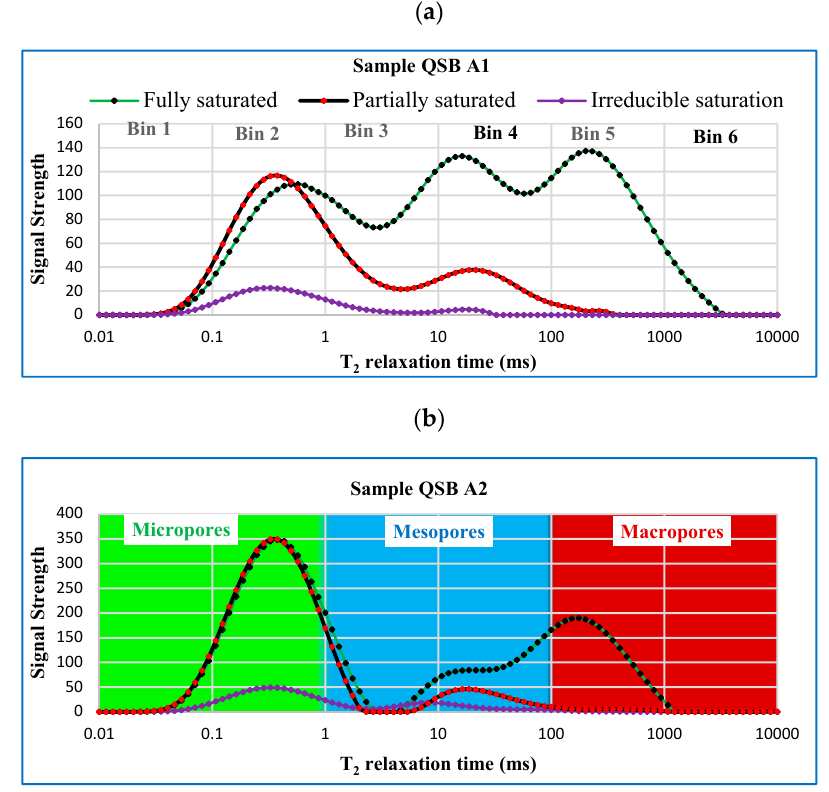
Figure 2. Nuclear magnetic resonance (NMR) T 2 relaxation curves obtained in the laboratory for Sample QSB A1 ( a ), and Sample QSB A2 ( b ) under the three states of water saturation, i.e., fully saturated, partially saturated, and irreducible saturation.